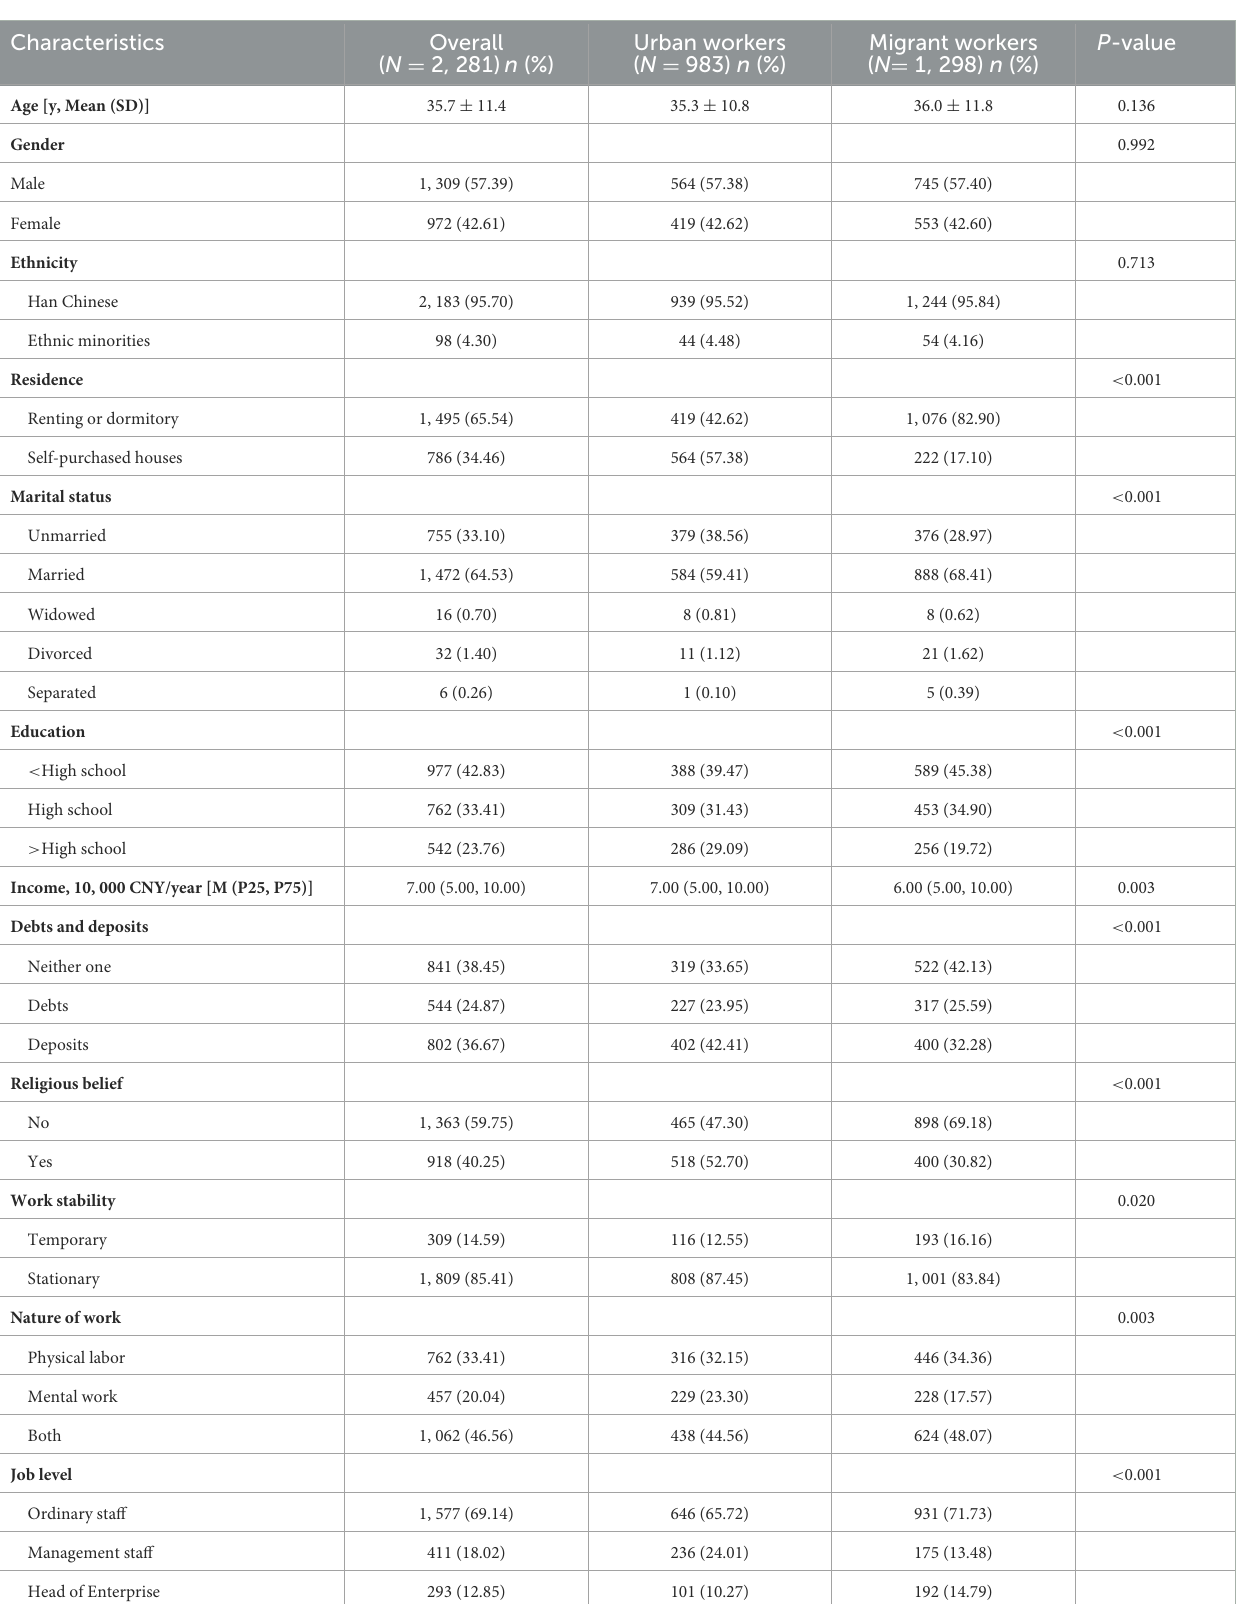
TABLE 1 Sociodemographic characteristics of the study population.